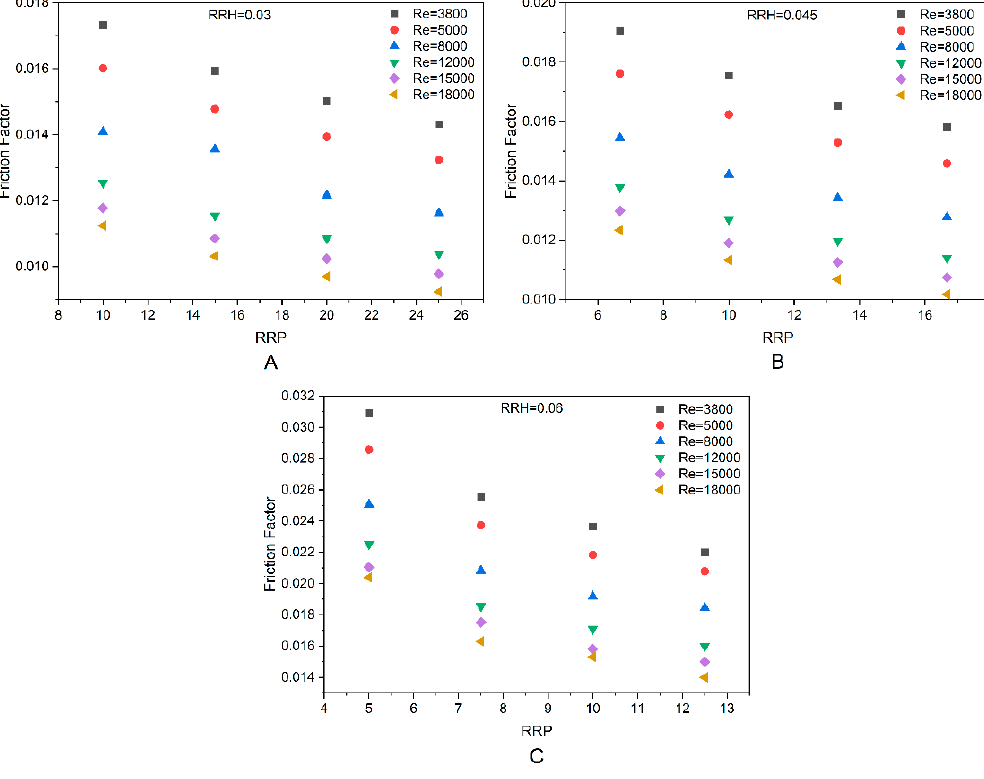
Figure 13. f r versus RRP for ( A ) RRH = 0.03 ( B ) RRH = 0.045 ( C ) RRH = 0.06.